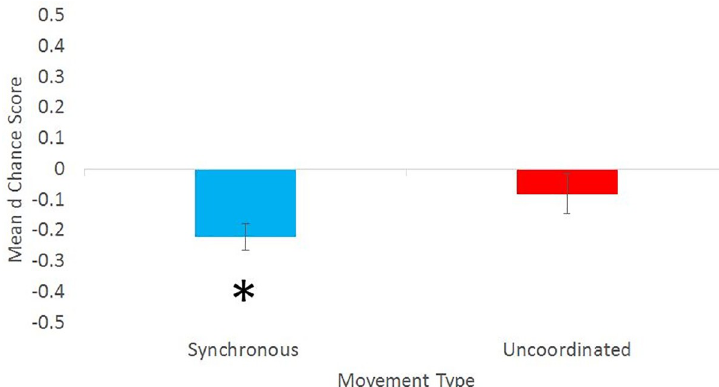
Fig 4. Means and standard errors for the d change